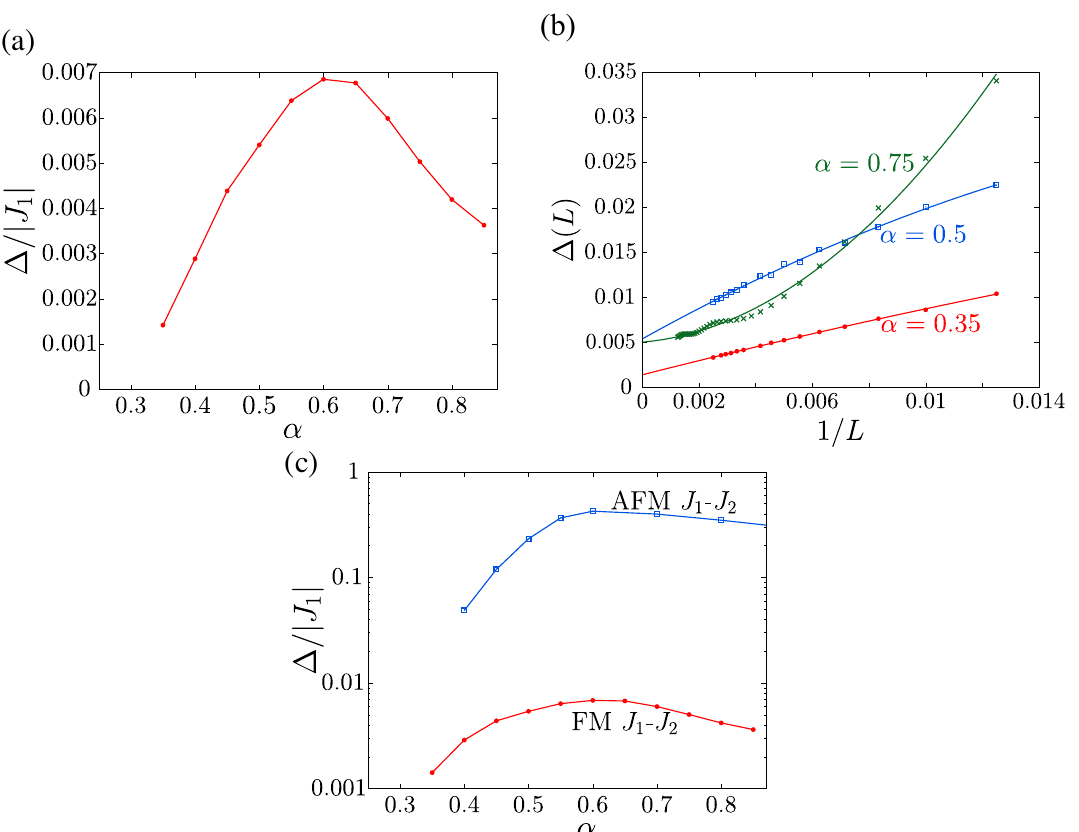
| of the J Figure 3: (a)Spin gap ∆ / | J - J chain as a function of the degree of frus- 1 1 2 tration α . (b) Examples of finite size scaling of the spin gap for α = 0.35 (red line), α = 0.5 (blue line) and α = 0.75 (green line). (c) Comparison between the gaps of − J the FM J and the AFM J - J chain on a semilog 1 2 1 2